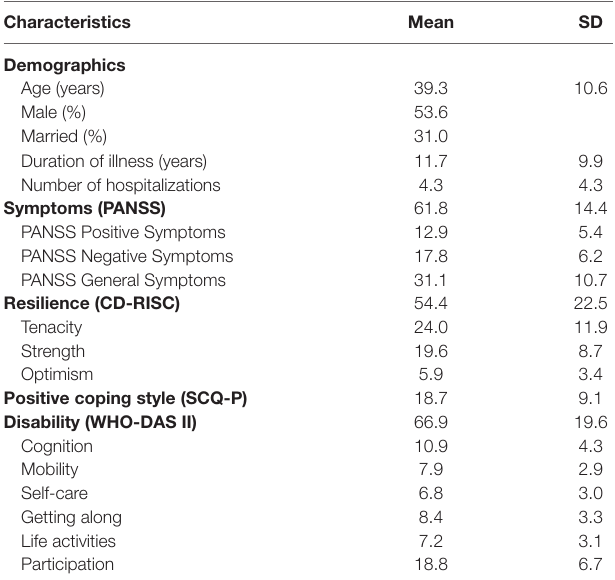
TABLE 1 | Sociodemographic characteristics and the means and standard deviations (SDs) of clinical characteristics ( n = 407).